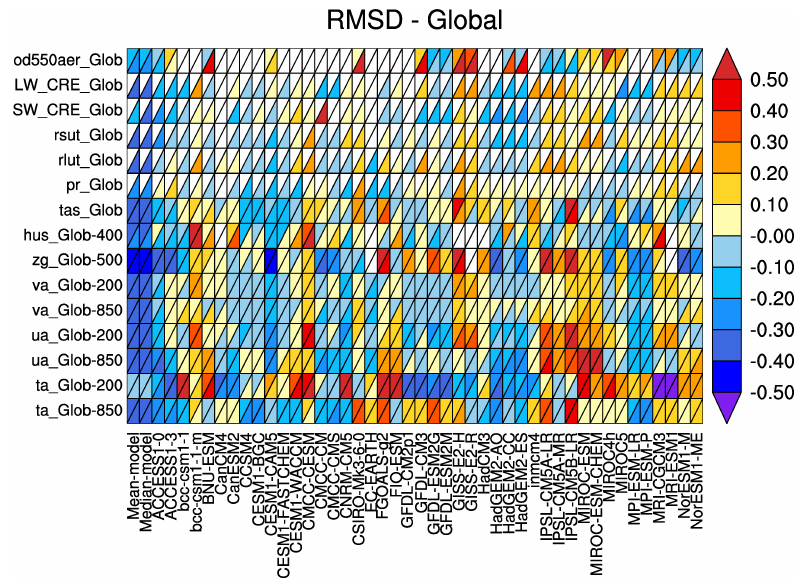
Figure 2. Relative space–time root-mean square error (RMSE) calculated from the 1980–2005 climatological seasonal cycle of the CMIP5 historical simulations. A relative performance is displayed, with blue shading indicating performance being better and red shading worse than the median of all model results. A diagonal split of a grid square shows the relative error with respect to the reference data set (lower right triangle) and the alternate data set (upper left triangle). White boxes are used when data are not available for the given model and variable or no alternate data set has been used. The figure shows that performance varies across CMIP5 models and variables, with some models comparing better with observations for one variable and another model performing better for a different variable. Except for global average temperatures at 200hPa where most but not all models have a systematic bias, the multi-model mean outperforms any individual model. Similar to Gleckler et al. (2008) and Fig. 9.7 of Flato et al. (2013) produced with namelist_perfmetrics_CMIP5.xml